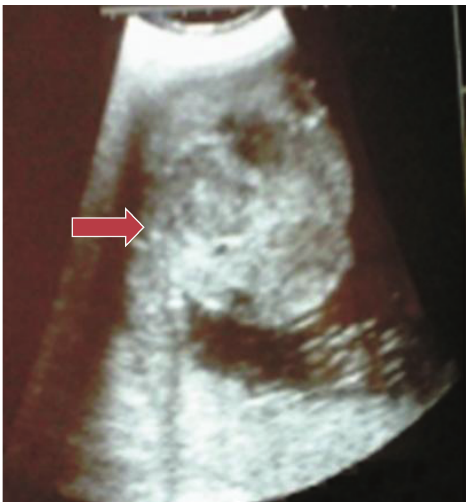
Figure 3: Microscopic examination of chorioangioma with lakes of blood vessels suggestive of angiomatous pattern, arrow indicating